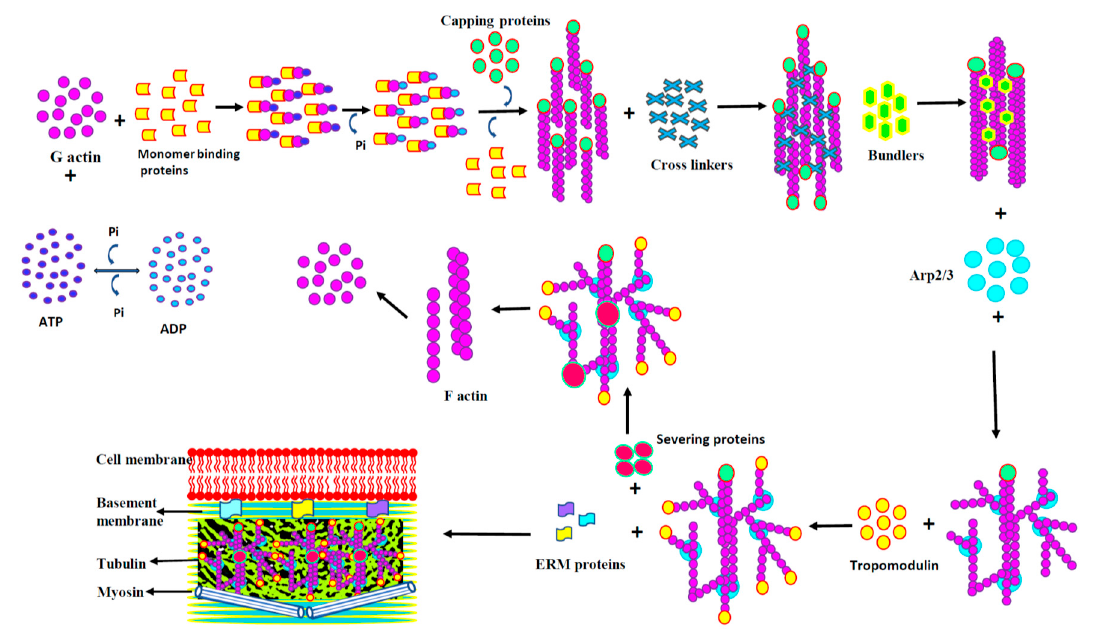
Figure 4. Actin-binding proteins. Figure 4 shows the graphical representation of proteins involved in the actin binding, capping, cross linking, bundling, severing, and anchoring.